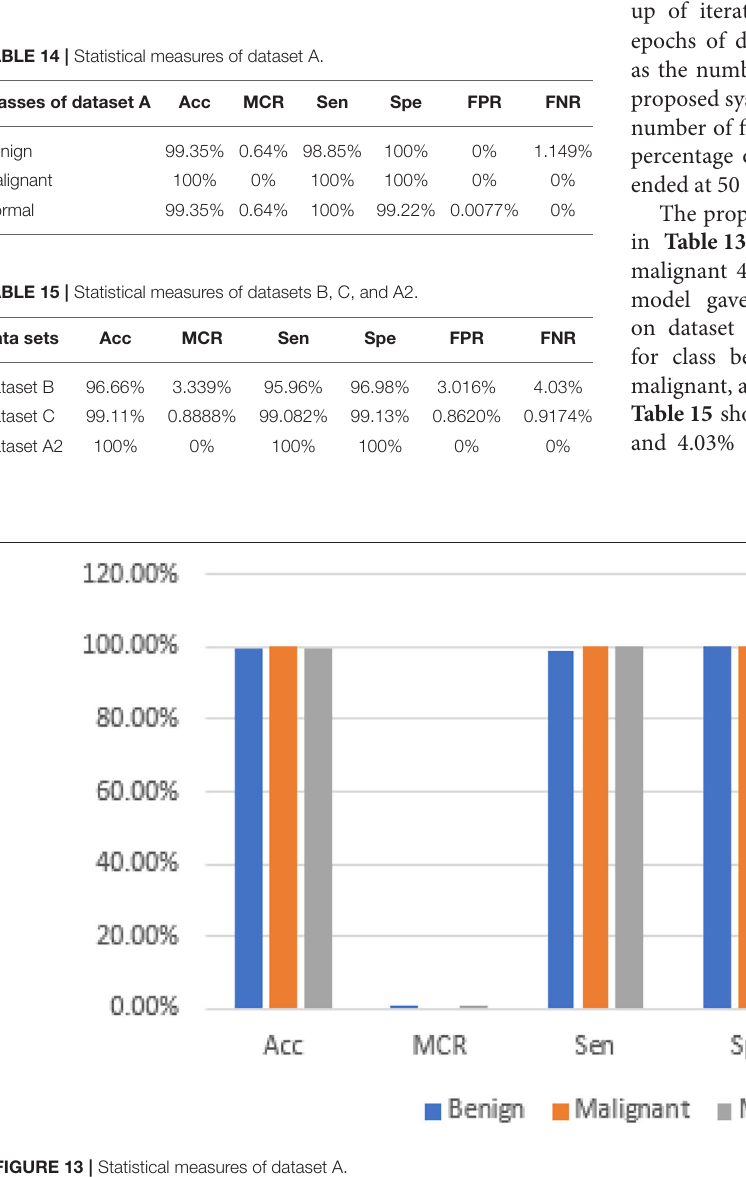
FIGURE 13 | Statistical measures of dataset